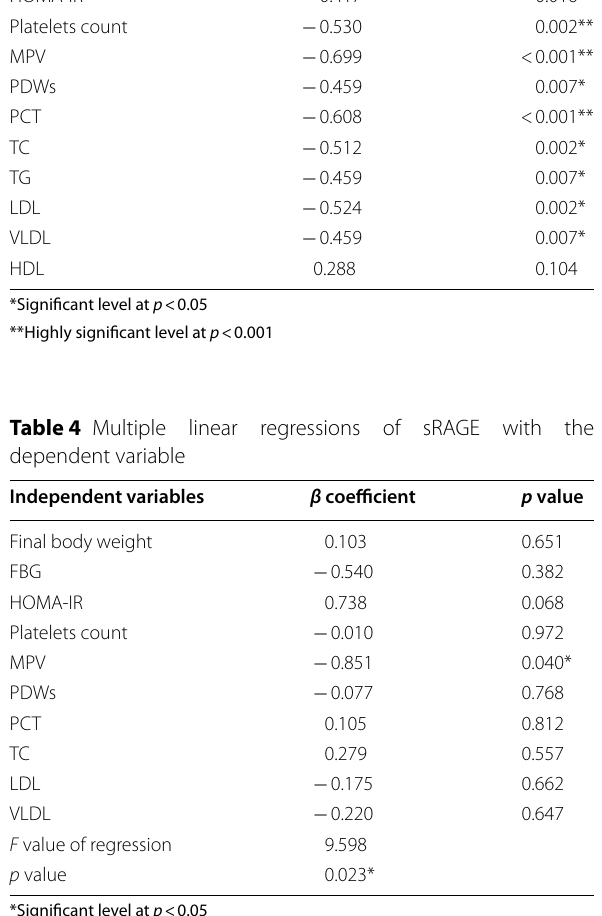
*Significant level at p <